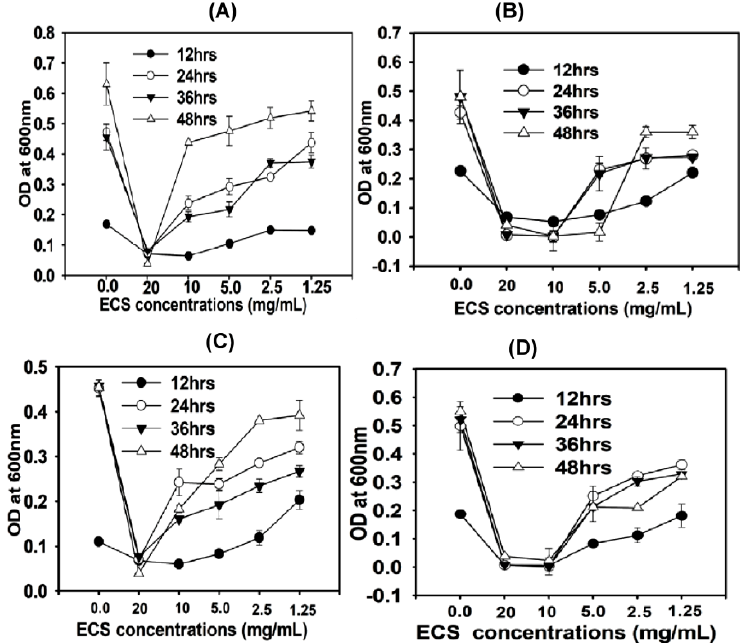
Figure 3. Antibacterial effects of ECS of TC48 on pathogenic bacteria as measured by time killing assay method. ECS of TC48 at different concentrations ranges from 20–1.25 mg/mL on E. coli ( A ), E. faecalis ( B ), P. aeruginosa ( C ) and S. aureus ( D ). Data represent the mean ± STD, ( n = 5).